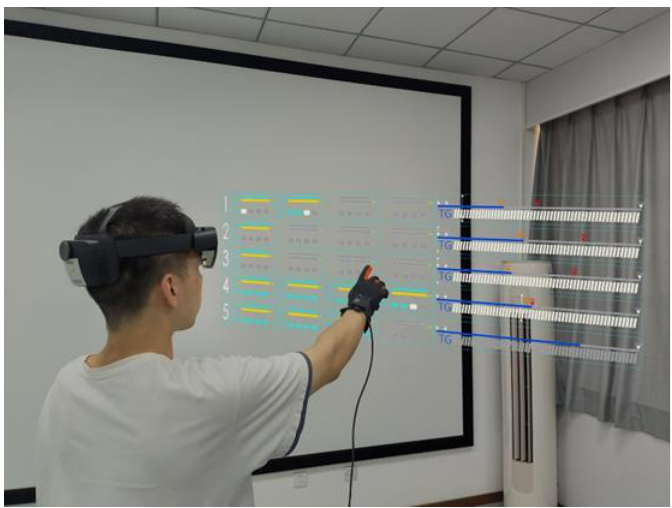
Figure 4. The scene of mixed reality combination in Experiment 1.